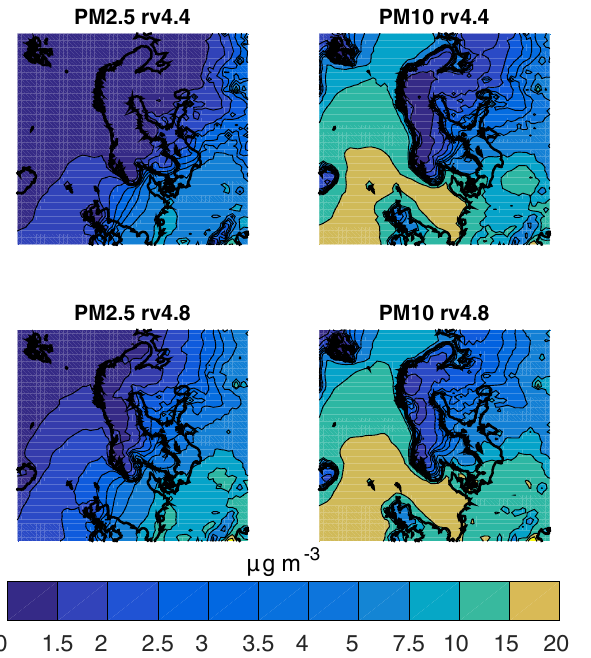
Figure 13. Annual mean concentration in 2011 of near-surface concentration (at 3m level) of particulate matter from all emission sources in the EMEP